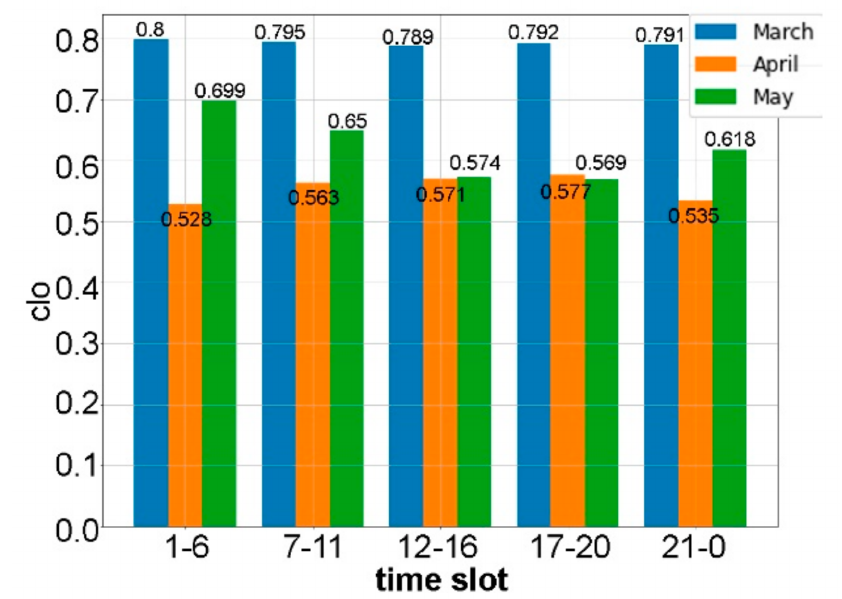
Figure 12. Average clothing insulation with the first testing